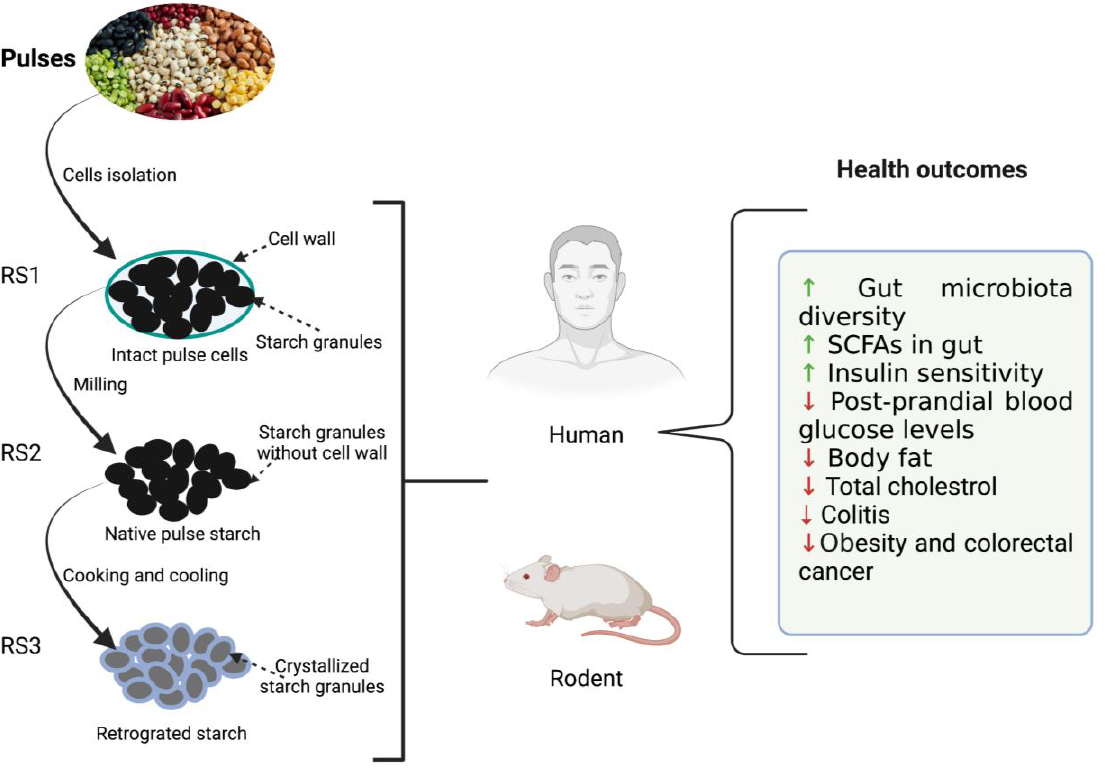
Figure 1. Illustration depicting the effects of resistant starches (RS) derived from dietary beans and pulses on host (rodent and human) health. ↑ : increased; ↓ : decreased.